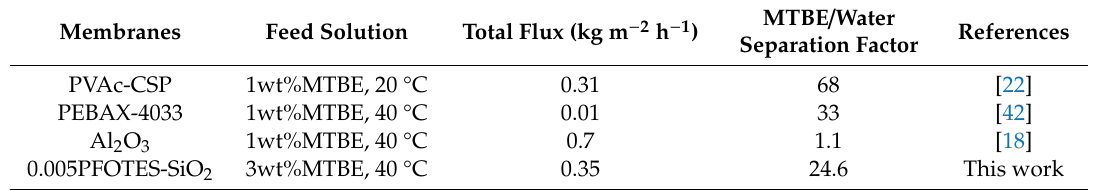
Table 2. Pervaporation performance of various membranes for MTBE / water separation.